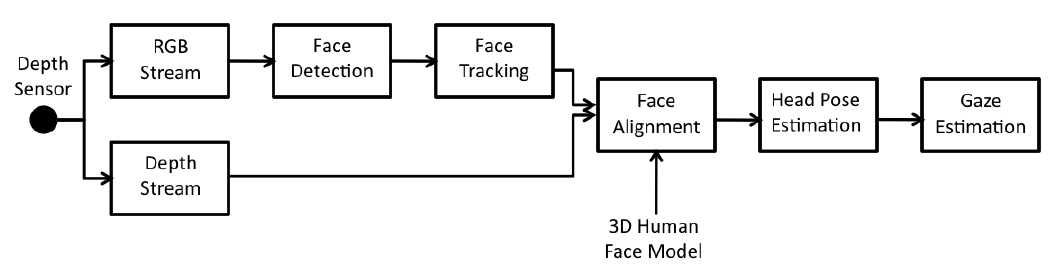
Figure 1. A block diagram of the proposed